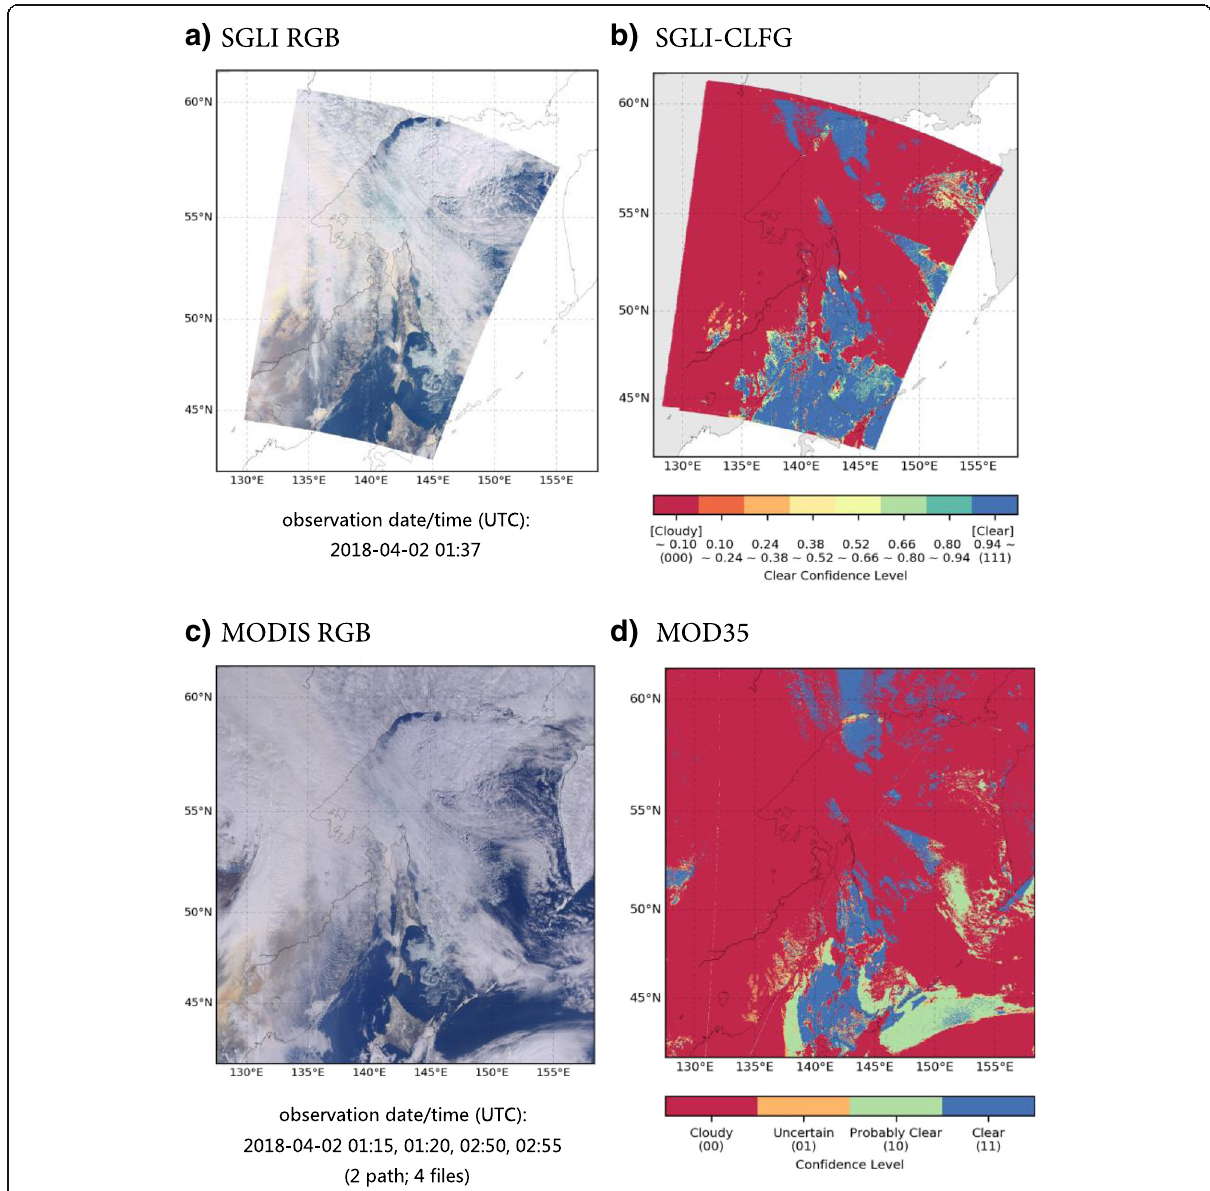
Fig. 16. Same as Fig. 12, but over the Sea of Okhotsk on April 2,